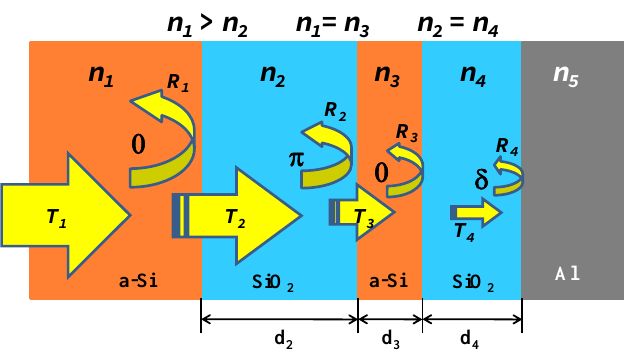
Figure 9. Diagram showing the propagation of a wave through the stratified 1 layer DBR + aluminum back reflector. The wave undergoes multiple reflections as it moves from one medium to the next. The corresponding phase change on reflection, the refractive indices and thicknesses of the individual layers are